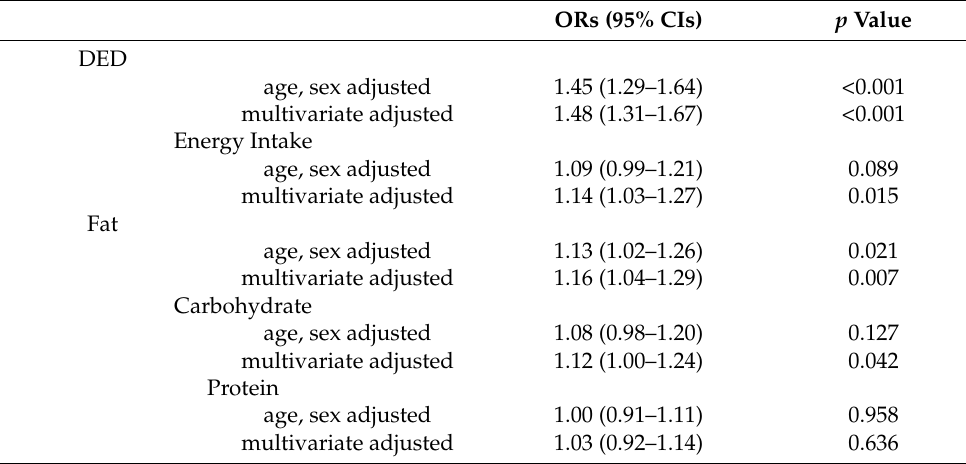
Table 4. ORs for obesity (BMI ≥ 25) with 95% CIs for per 1 SD increment of DED, intake of energy,